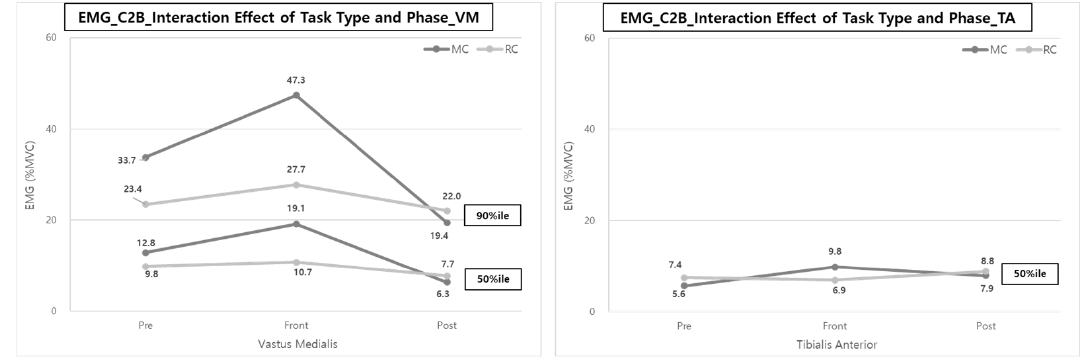
Figure 11. Interaction effect of task type and phase on VM & TA muscle activities during C2B.